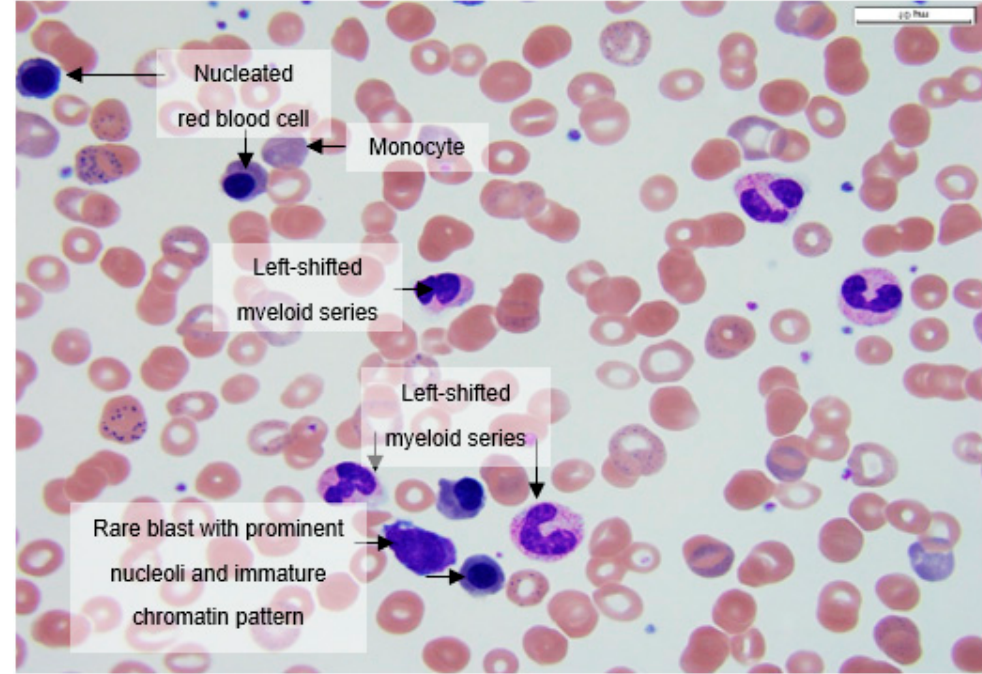
Figure 2. Peripheral smear at 100 × magnification showing a nucleated erythroid, a rare blast with prominent nucleoli and immature chromatin pattern, a left-shifted myeloid series with immature promyelocytes and metamyelocytes, and occasional monocytes.